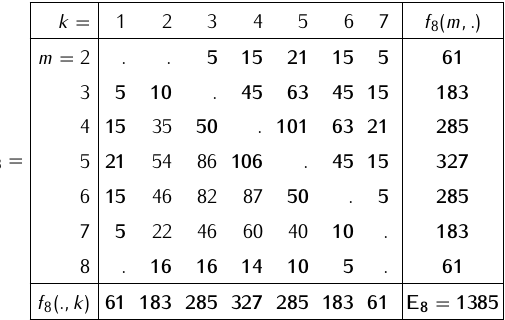
Table 3. The matrix M